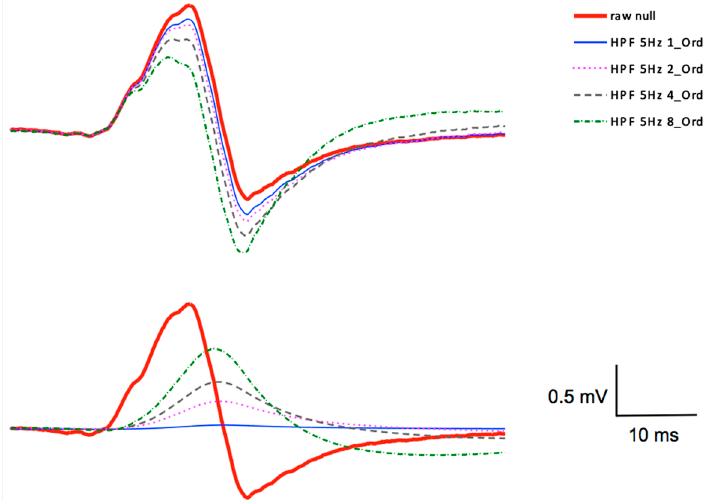
Figure 7. The surface electromyogram of the unfiltered MEP is shown as a continuous red line from the same subject as before. The signal was filtered with a 5 Hz Butterworth HPF with different orders, a filter with 1st-order, with 2nd-order, with 4th-order and with 8th-order was chosen for comparison. The time window in this graph was 100 ms in duration. The 1st-order filter shows the smallest difference compared to the raw signal. The lower graph shows the areas of deviation of the different filtered signals to the unfiltered MEP.